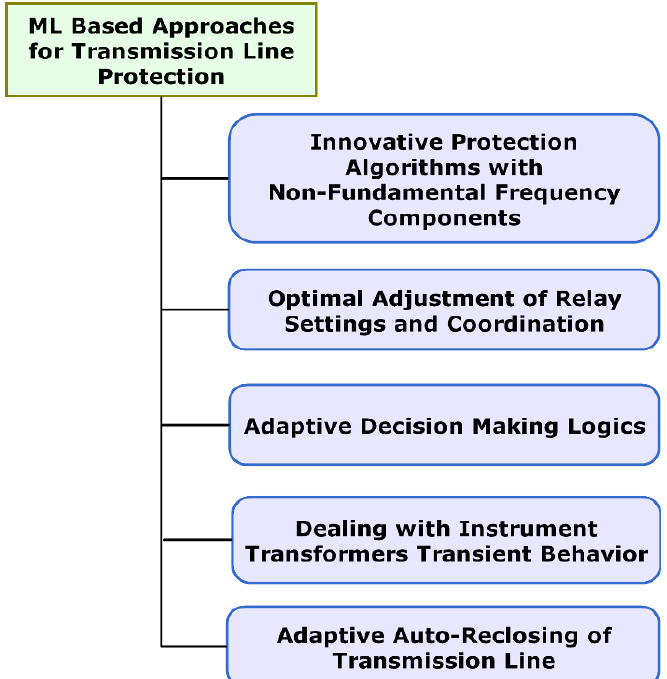
Figure 5. Transmission line protection using a machine learning